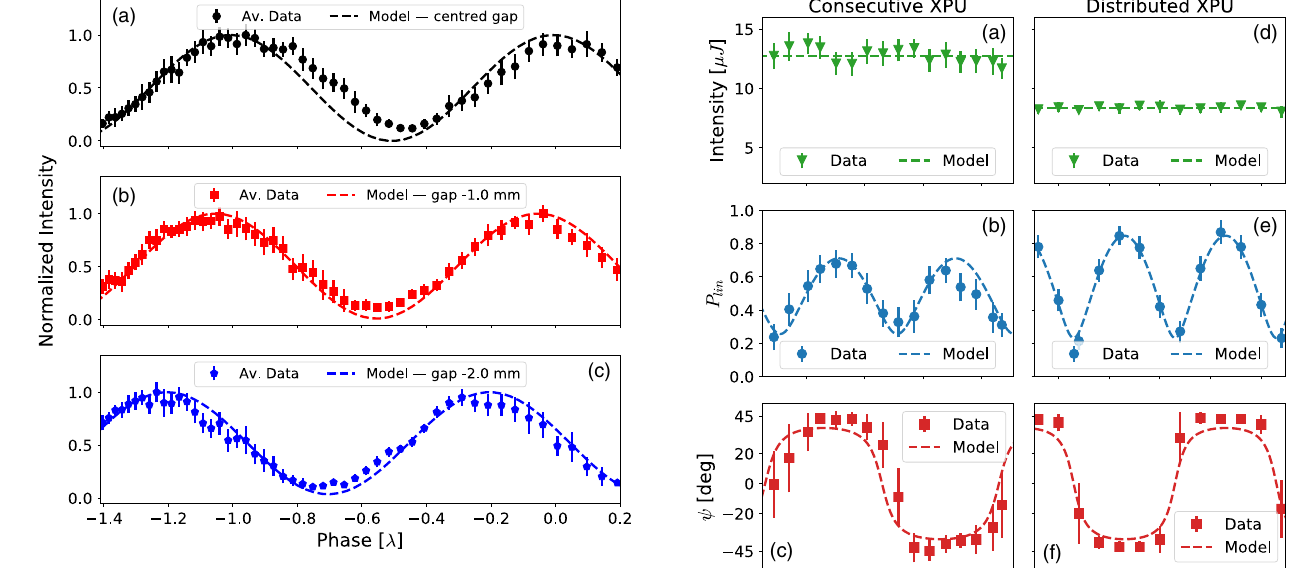
FIG. 11. Left: Experimental data (points) and model prediction (dashed lines) for the scan of the phase between two unipolarized sources, for different aperture ’ s locations along the wavefront of the beam. All the undulators were set to linear vertical polari- zation. Each experimental point is the average over 20 consecu- tive shots, the error bars are the standard deviation.